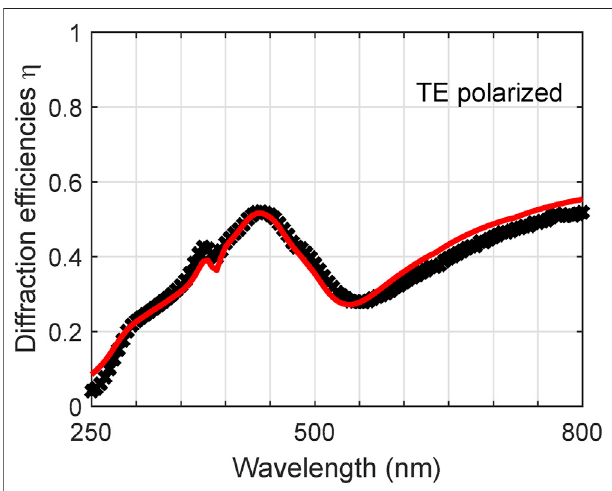
[23]. The state of polarization of light can be visualized with the polarization ellipse and explained by two parameters: the ellipticity e and the azimuth angle ϕ . We will also use the ellipticity angle ε (cid:1) arctan( e ). The parameters ε and ϕ are related to the Stokes vector S in Eq. 11 , which for the special case of incident unpolarized light can be expressed as [24].